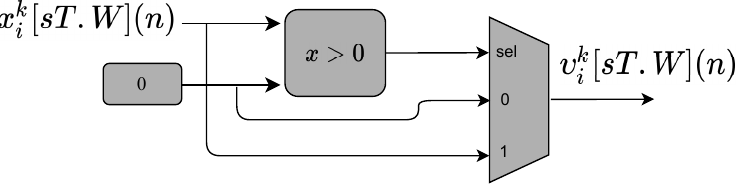
Figure 13. Block diagram representing the circuits used to implement the ReLU function ( f ( . ) ) submodule in Figure